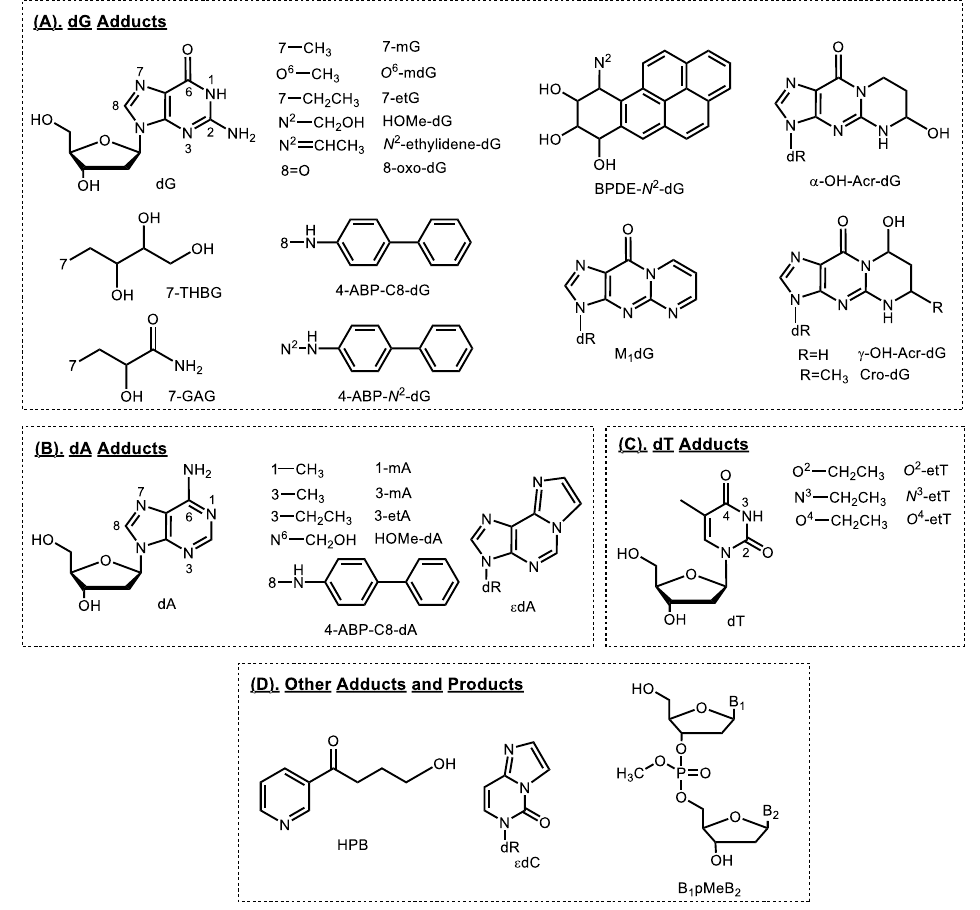
Figure 2. Structures of DNA adducts detected in humans. dR, 2′ -deoxyribose; HPB, 4-hydroxy-1-(3- pyridyl)-1-butanone.